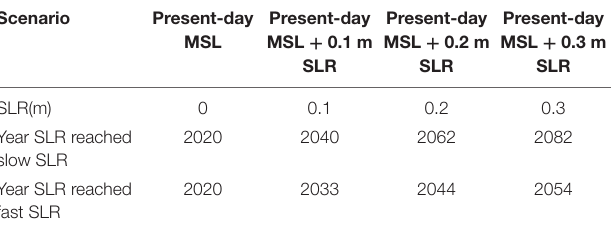
TABLE 2 | Expected year to reach 0, 0.1, 0.2, and 0.3 m SLR relative to 2020 base year, for fast and slow SLR scenarios Slow SLR scenario is RCP 2.6